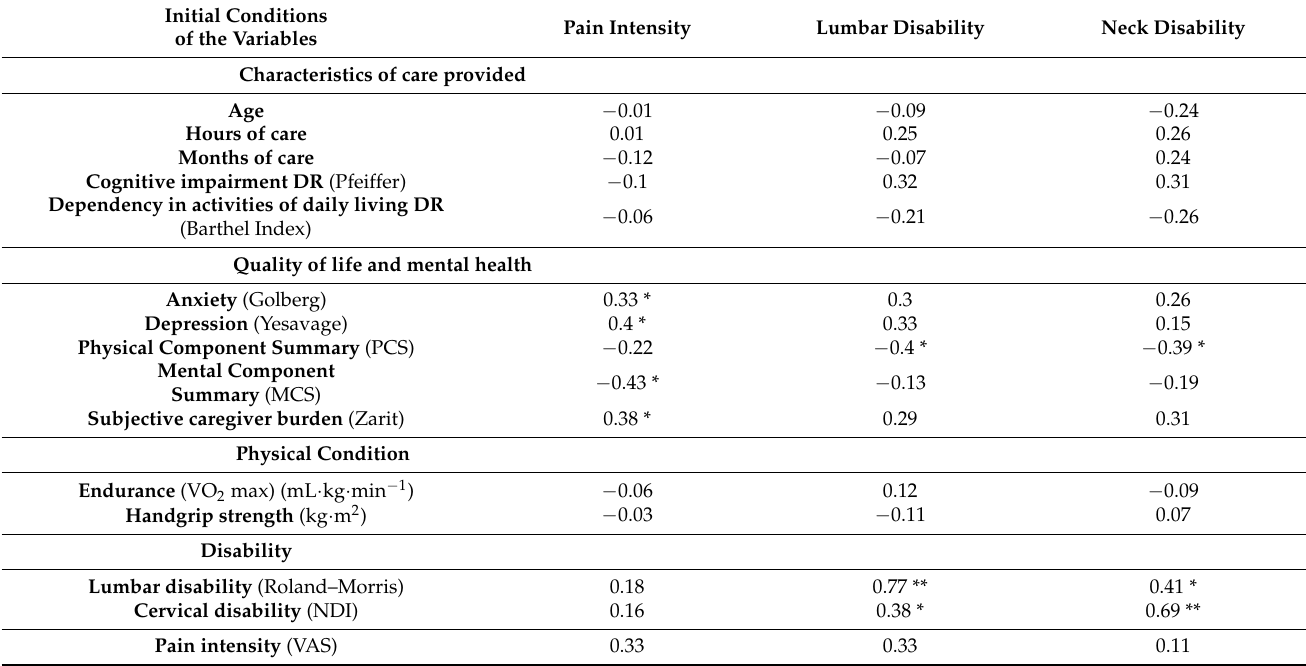
Table 7. Correlations between the initial situation of the caregivers and changes in the study